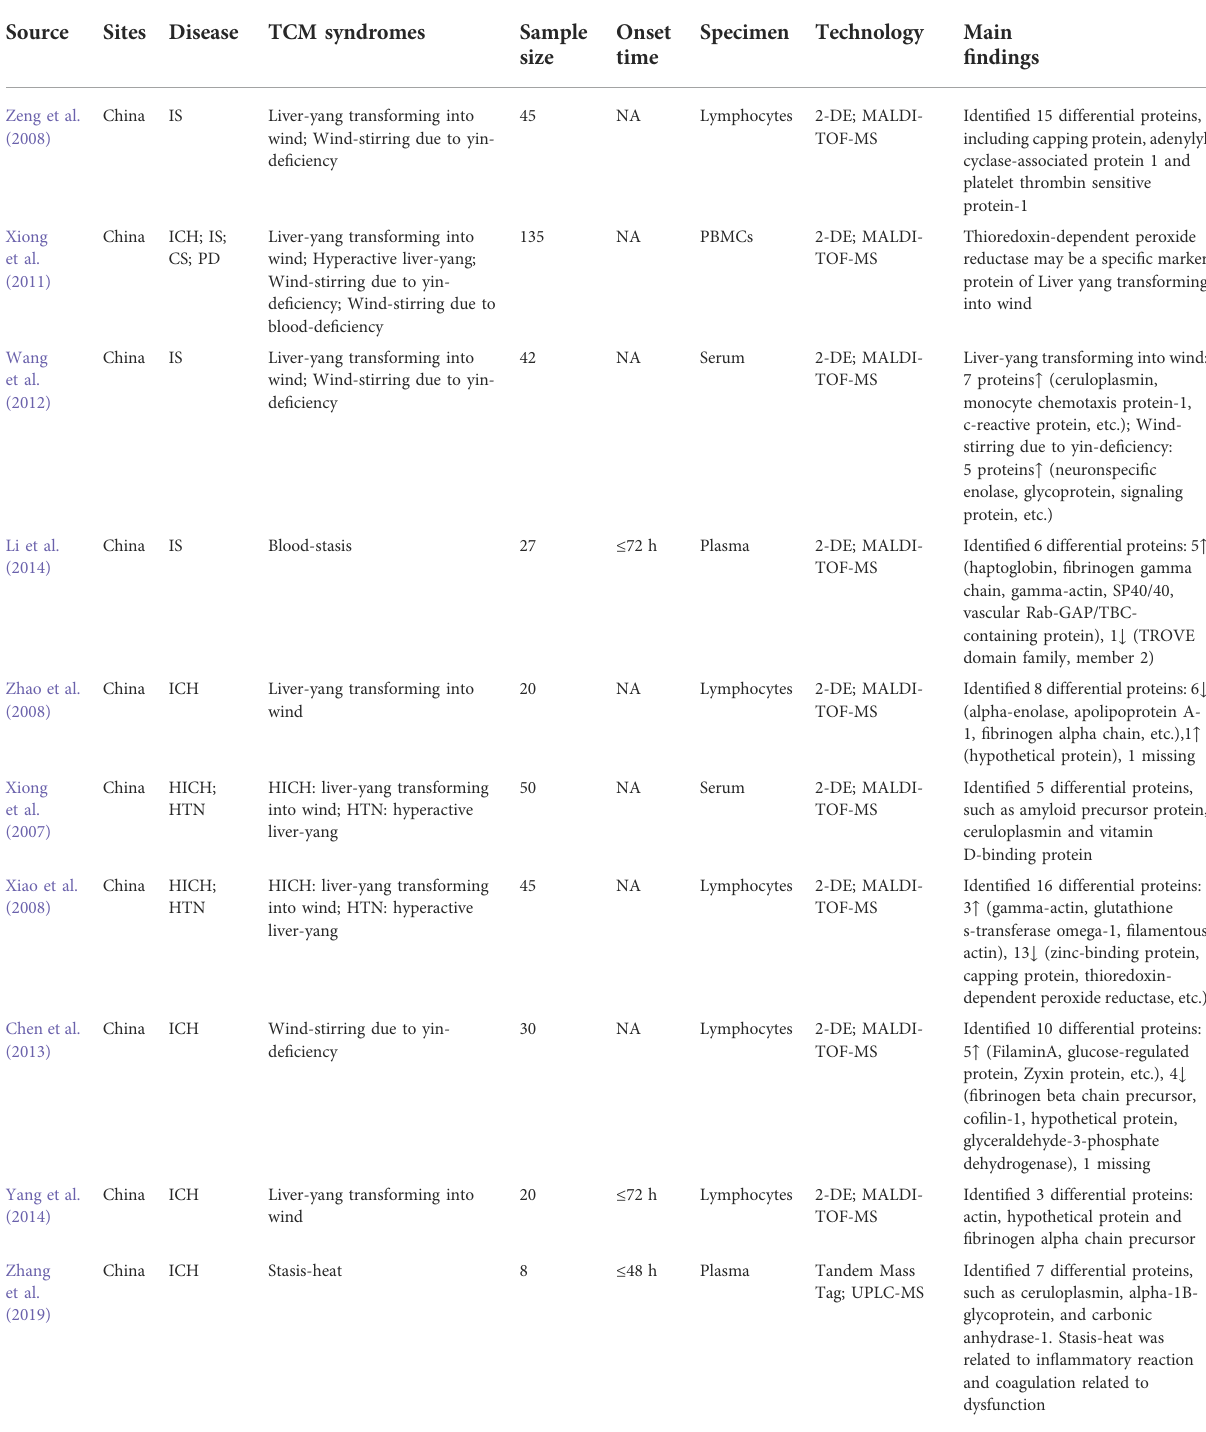
TABLE 3 Summary of the main fi ndings of the included proteomics